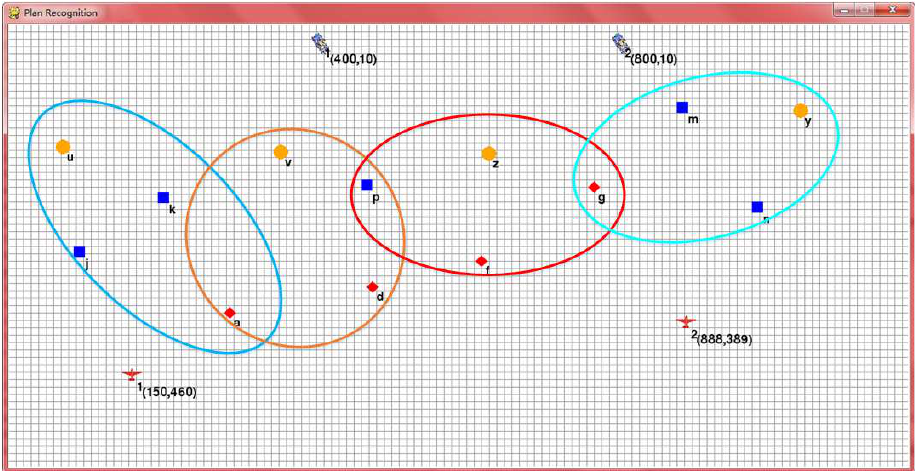
Figure 2. Simulation scene where the red planes (the attackers controlled by a human operator) go against the tanks controlled by our proposed